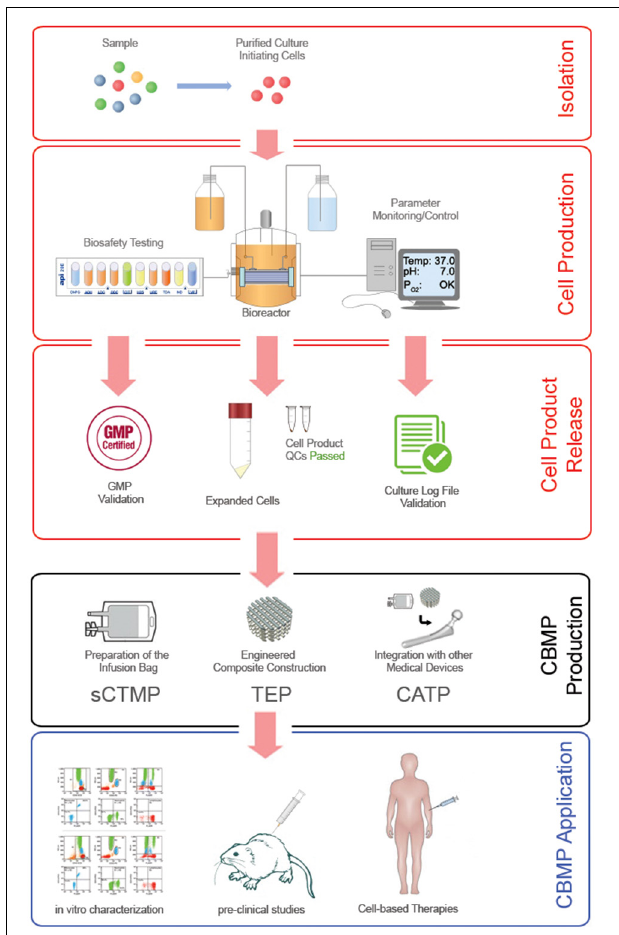
FIGURE 4 | Ideal MSC-based CBMP production process. Robust reproducibility in the MSC expansion/production process (red frames) can be achieved by applying specific isolating methods that are able to supply defined culture-initiating cells, and highly controlled cell expansion cultures conducted in computerized close systems. Final product release should be subjected not only to GMP validation to ensure the bio-safety of the cell product, but also to quality control validation of the entire production process. Monitoring and control of environmental parameters can significantly increase the predictability of the in vitro characterizations and pre-clinical studies. In fact, drastically reducing the batch-to-batch heterogeneity of expanded MSCs and consequently of the CBMP produced (black frame) for different applications (blue frame) could result in less variation in the clinical outcome, and lastly improve the efficacy of cell-based